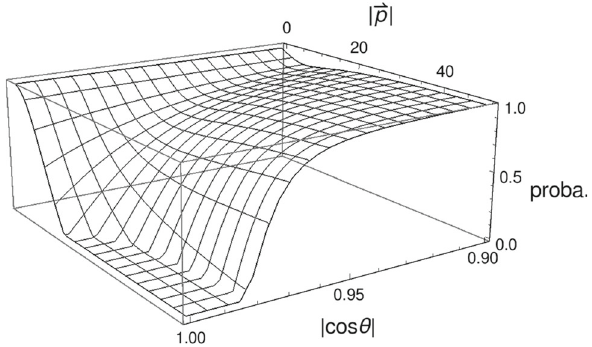
Fig. 5 The probability distribution of J /ψ meson with momentum p